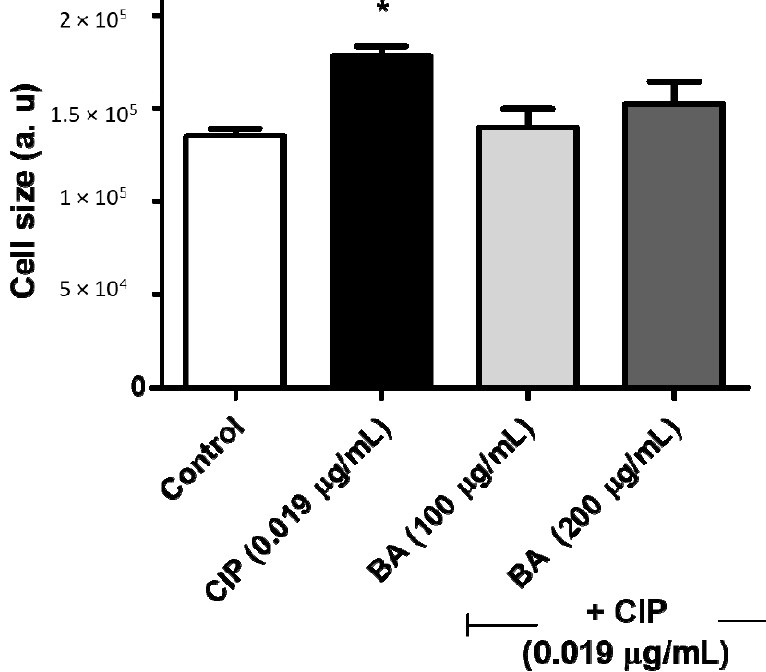
Figure 3. Effects of betulinic acid in the increase of cell volume induced by ciprofloxacin. S. aureus ATCC 6538 was incubated with ciprofloxacin (0.019 µg/mL) alone or in combination with betulinic acid (100 or 200 µg/mL) and after 3 h, the cell volume was determined using flow cytometry. CIP—ciprofloxacin; BA—betulinic acid. * indicates statistical differences related to the untreated cells ( p < 0.05).